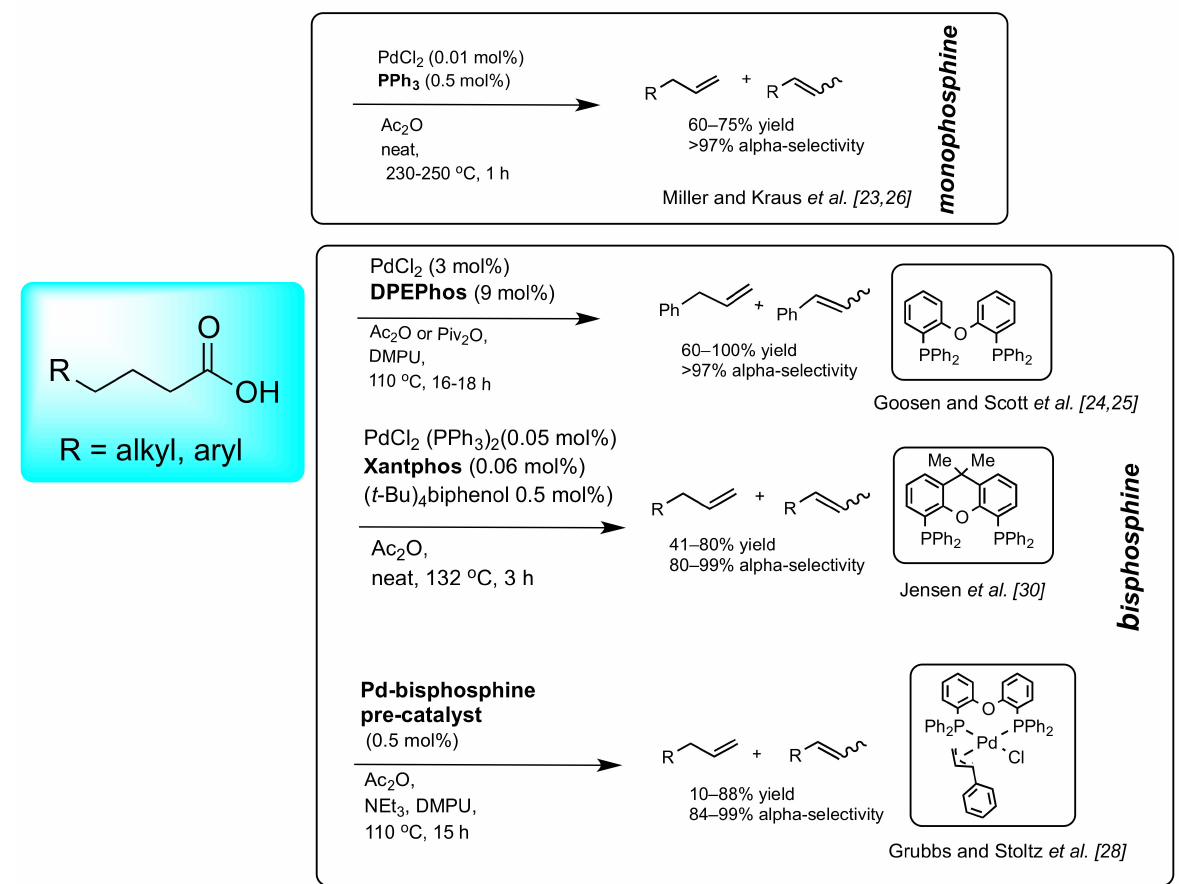
Figure 1. Palladium-catalyzed decarbonylation of carboxylic acids into